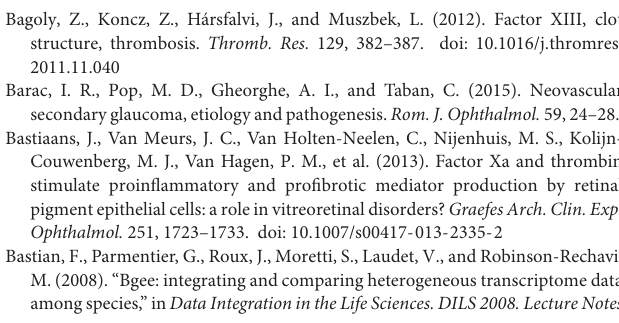
TABLE S3 | Detailed AH protein list of 4 previous studies and our study.